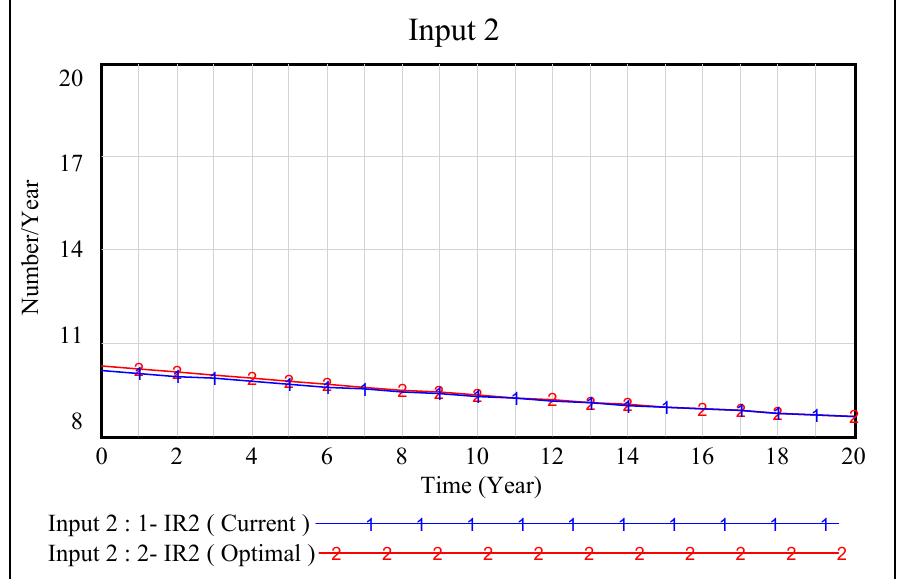
Figure 14. The comparison diagram of the effect of the current and optimal input rate 2 on the input current variable 2.